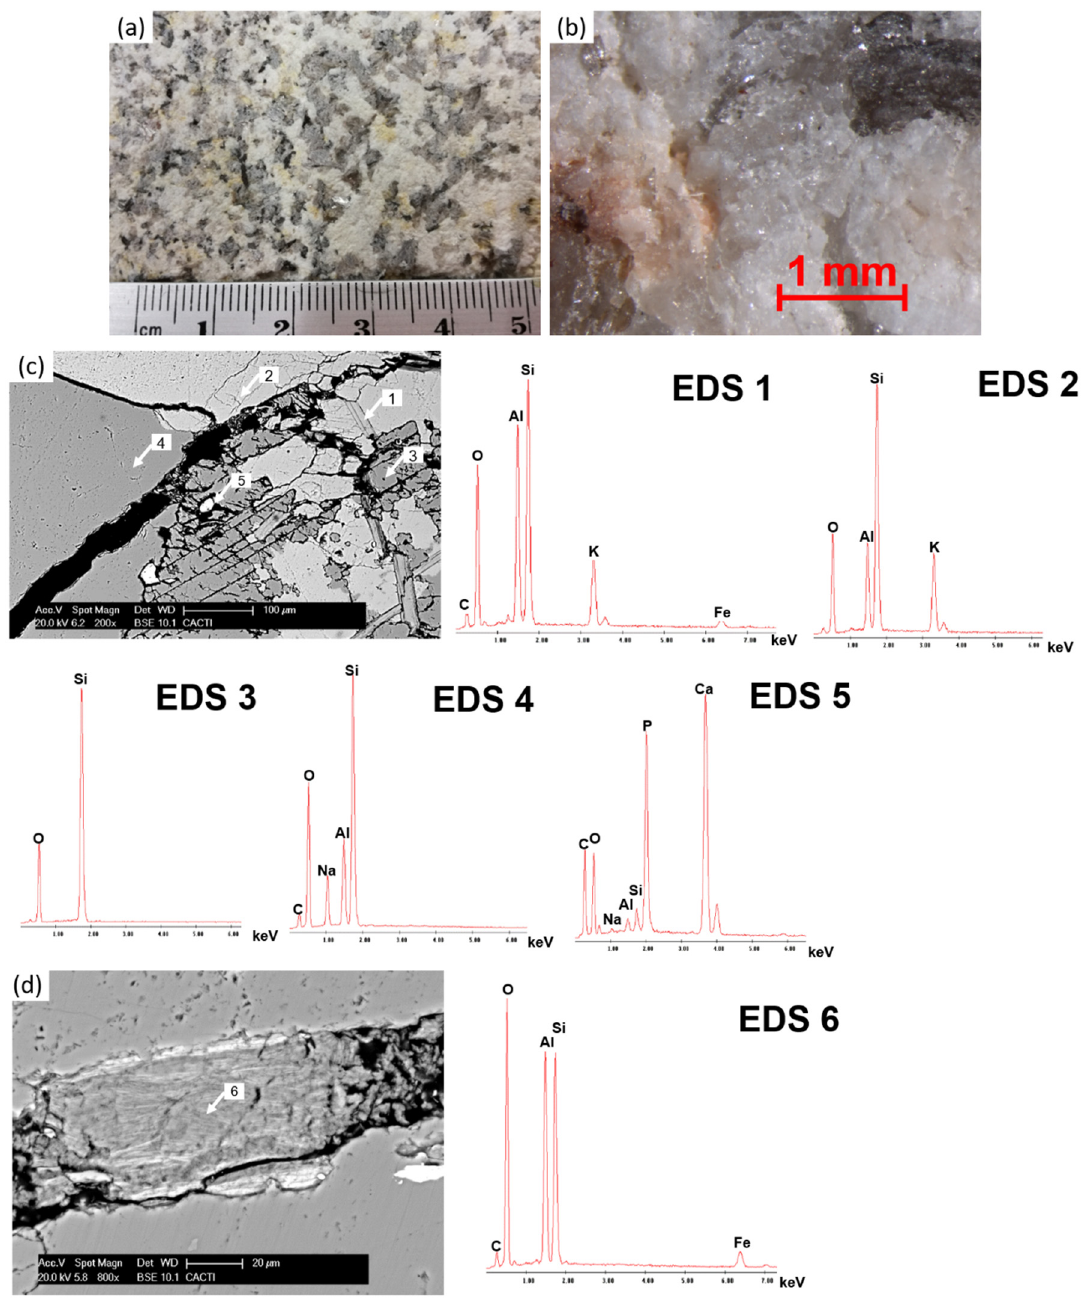
Figure 1. Rodas granite. ( a ) Digital photograph; ( b ) Micrograph taken with stereomicroscopy. ( c , d ) SEM micrographs of a polished cross section of the reference granite and EDS spectra of the granite. EDS1: biotite, EDS2: K feldspar, EDS3: quartz, EDS4: Na plagioclase, EDS5: apatite, EDS6: Al-, Si-, and Fe-rich deposits filling fissures.